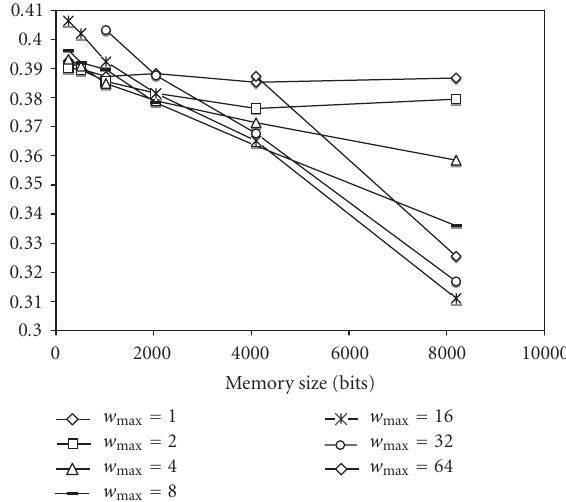
Figure 8: Impact on logic energy when increasing memory size.